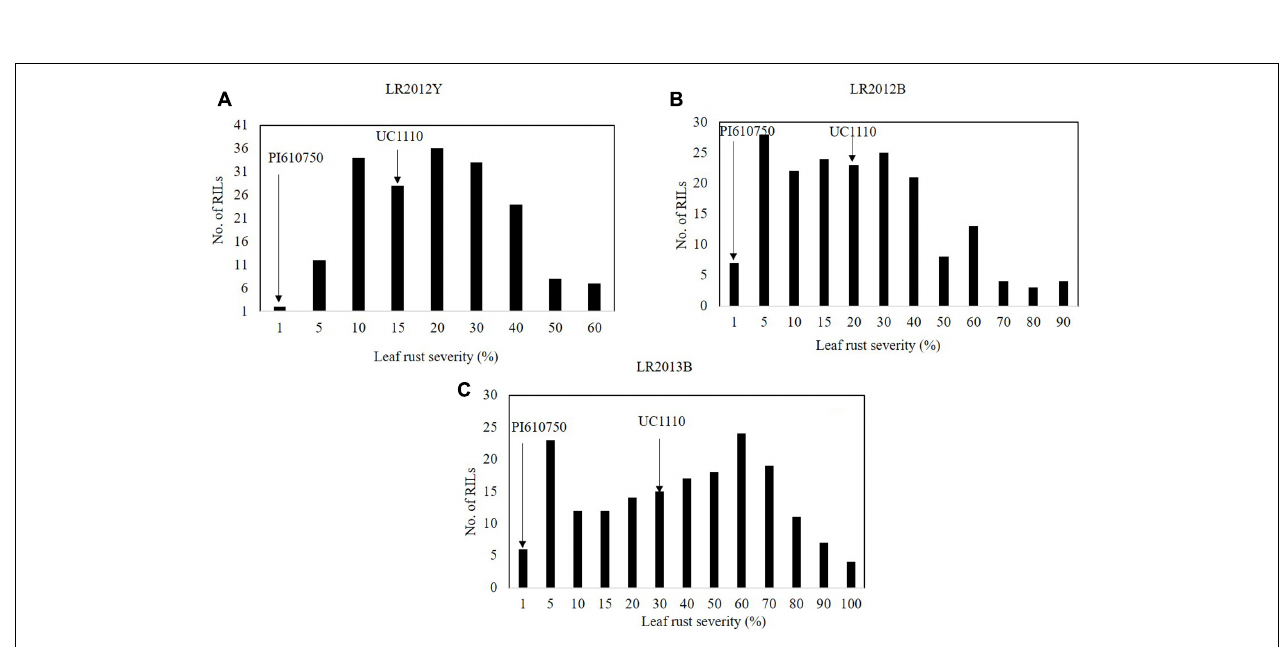
FIGURE 3 | Frequency distributions of UC1110/PI610750 recombinant inbred lines (RILs) for final leaf rust severity in field trials (A) at Ciudad Obregón in 2012 (LR2012Y, (B) at El Batán in 2012 (LR2011B), and (C) at El Batán in 2013 (LR2012B). The leaf rust severities for PI610750 and UC1110 are indicated by arrows.